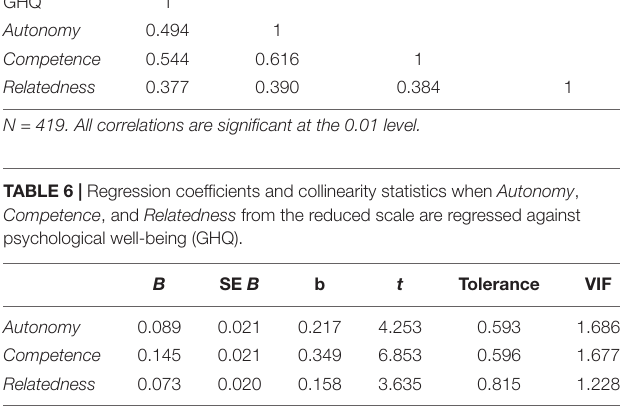
TABLE 5 | Pearson correlations between psychological well-being (GHQ) and a composite score of each basic need on the reduced scale (manifest values). GHQ Autonomy Competence Relatedness